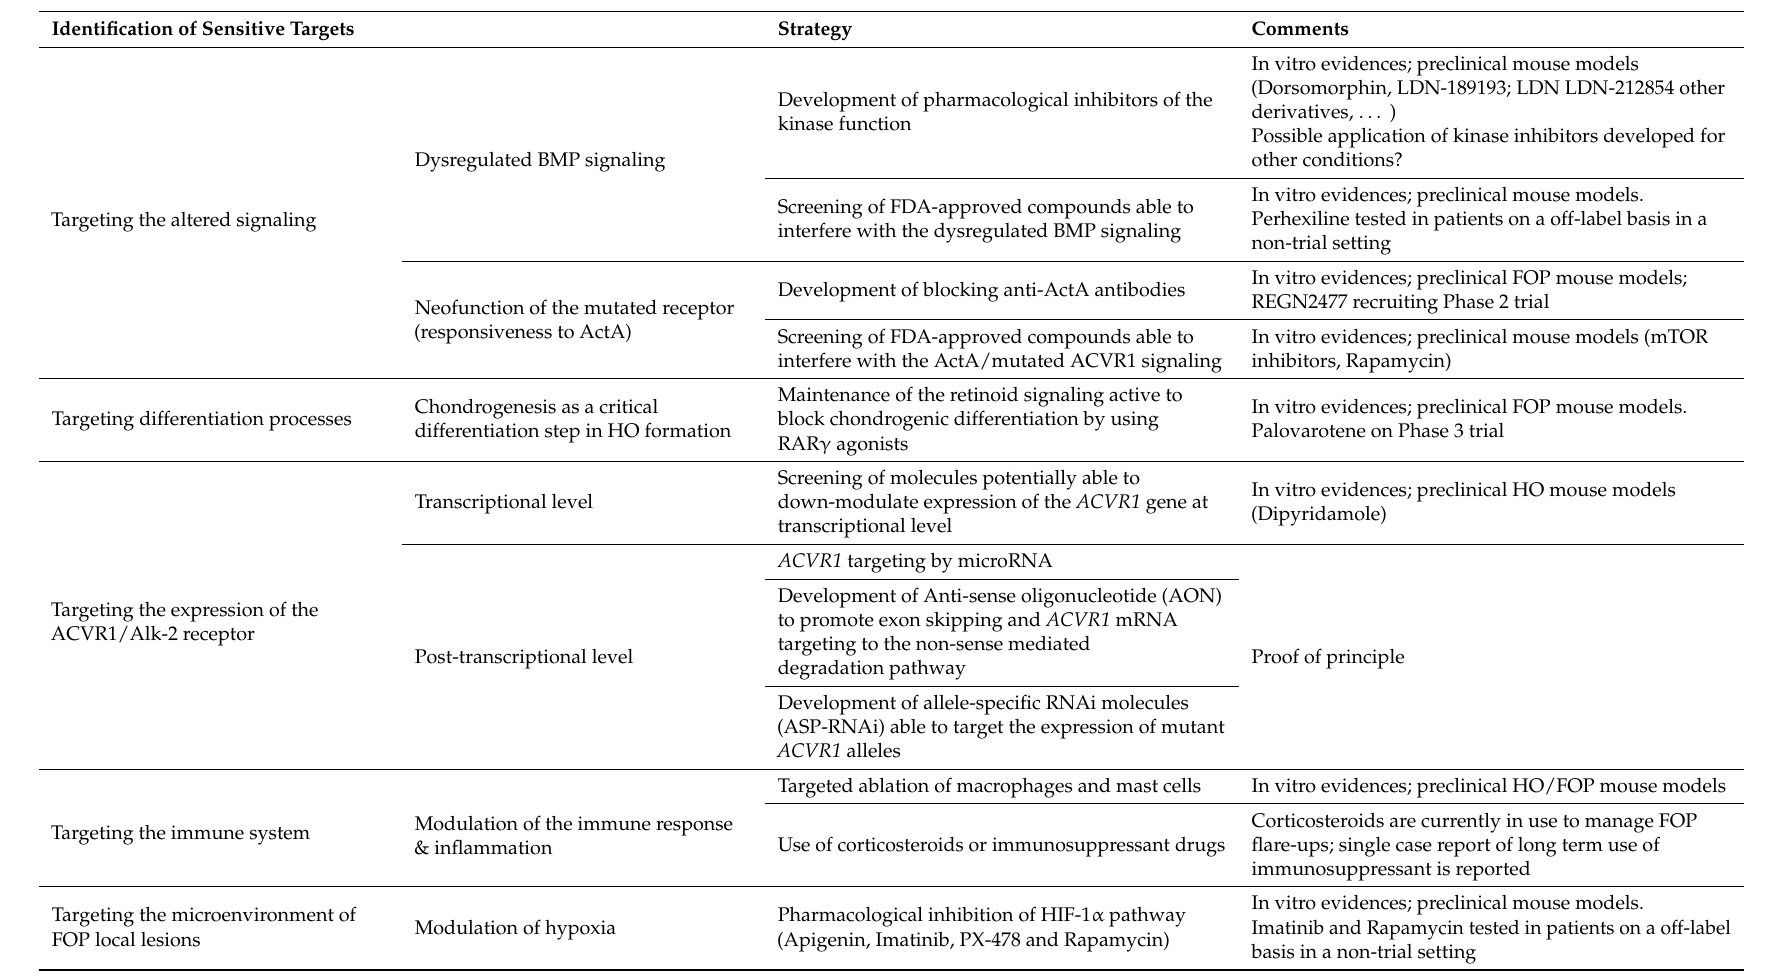
Table 3. Druggable targets and recent approaches to develop a treatment for